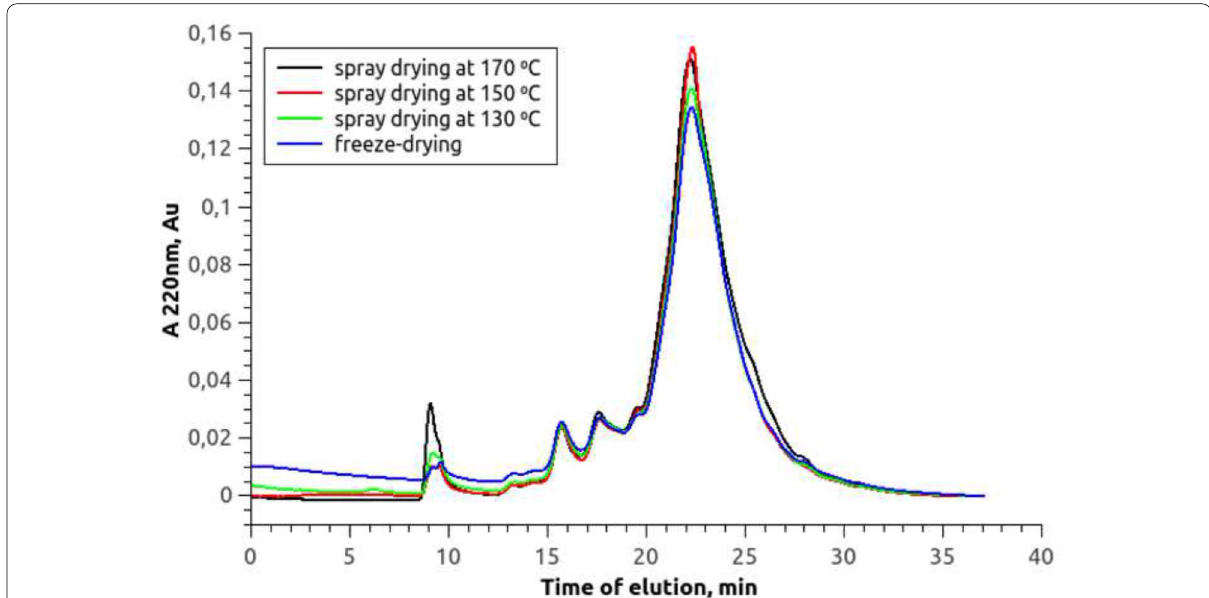
Fig. 7 Chromatograms of SPI hydrolysate after freeze and spray drying at different temperatures The SPI hydrolysate was obtained by enzymatic buffering